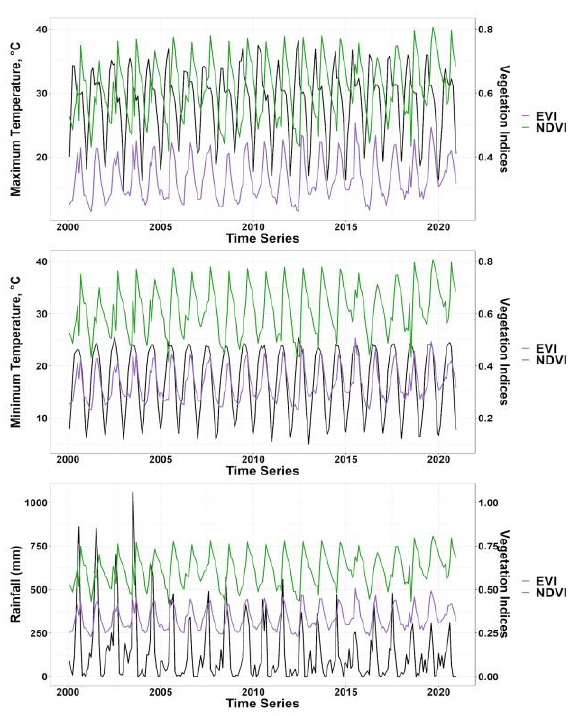
Figure 9. Temporal variation of vegetation indices and Climate Parameters in the Champawat District